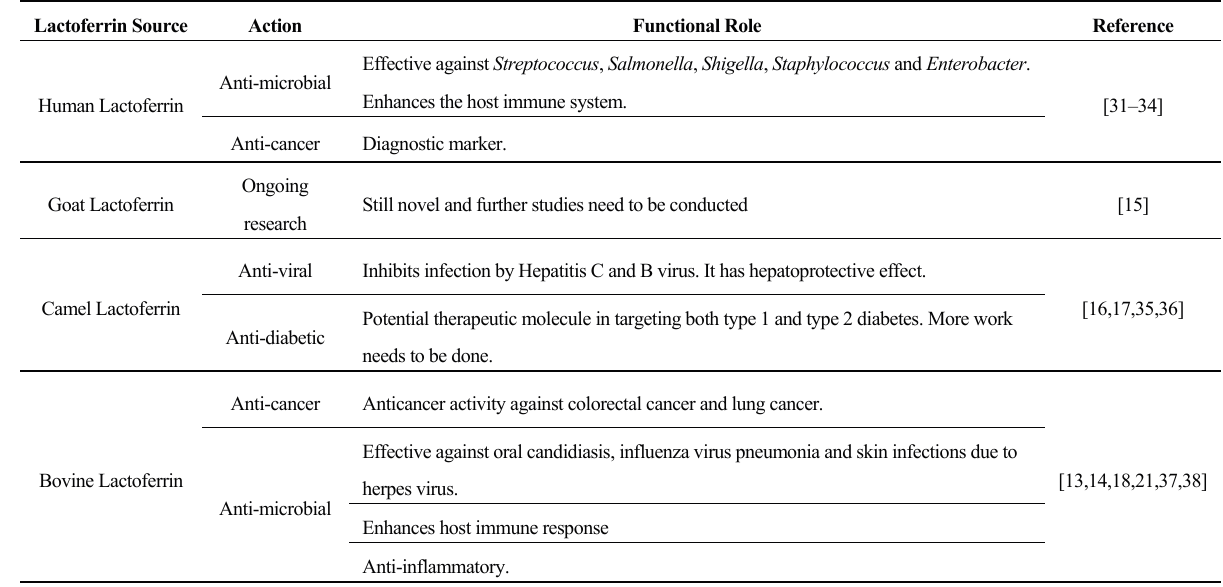
Table 1. Lactoferrin: various sources, functions and